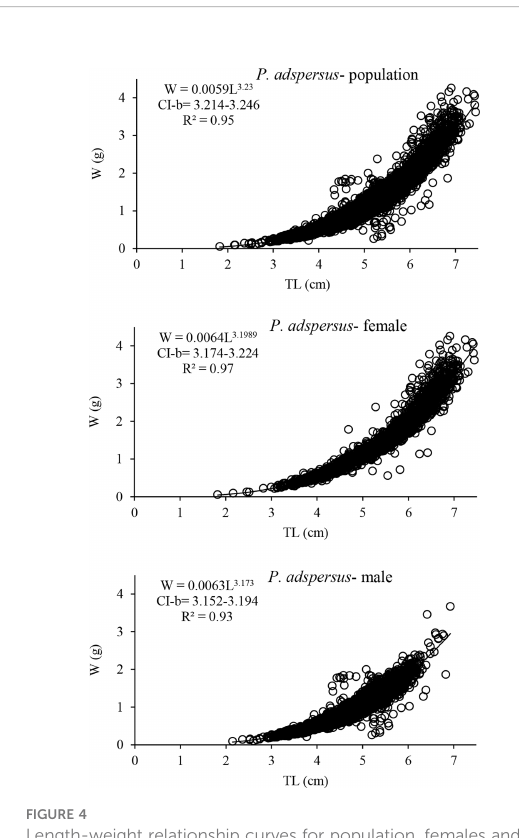
FIGURE 5 Length – weight relationship curves for population, females and males of P. elegans from the southeast Caspian Sea (2019 –